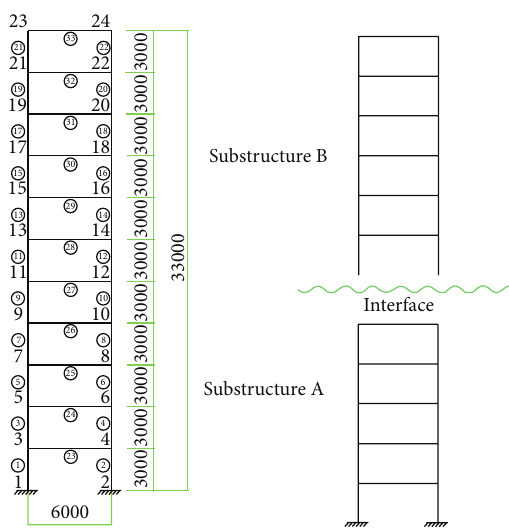
Figure 1: Eleven-storey frame structure (unit: mm).